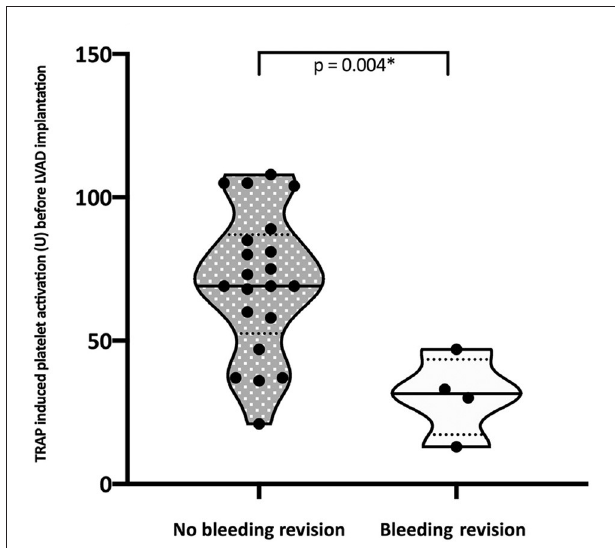
FIGURE 2 | TRAP-induced platelet aggregation before LVAD implantation in patients with and without surgical bleeding revision (TRAP, thrombin receptor activator peptide-6) measured by the Multiplate ® Analyzer (Roche Pharma AG, Grenzach-Wyhlen, Germany); the violin plots showing median with IQR and the density plot width; U, units; *Non-parametric Mann-Whitney U-test.